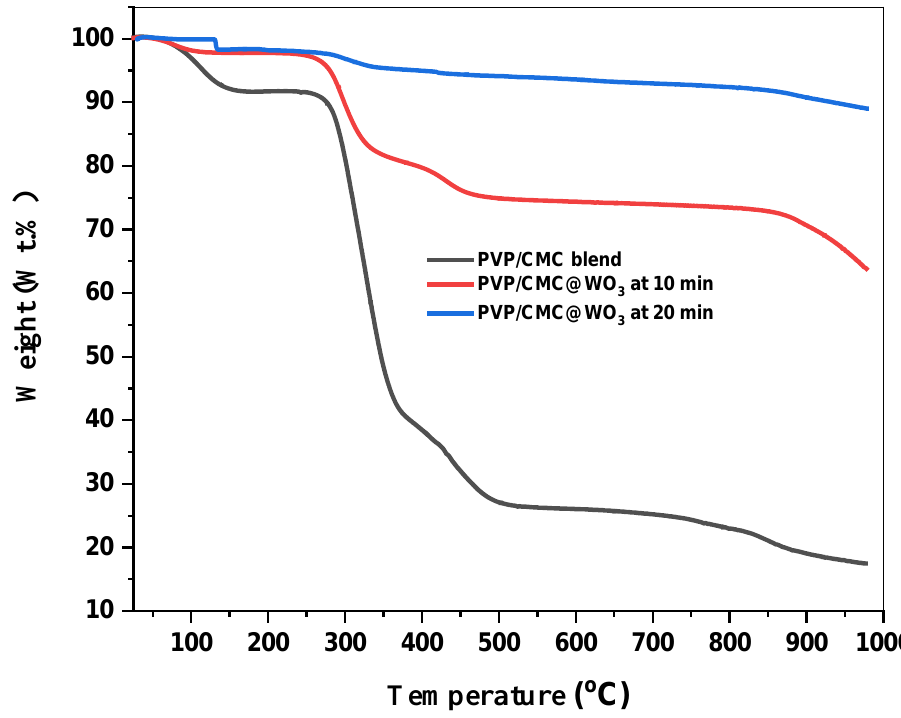
Figure 4. TGA curves of PVP/CMC and blend filled with WO 3 at 10 min and 20 min.